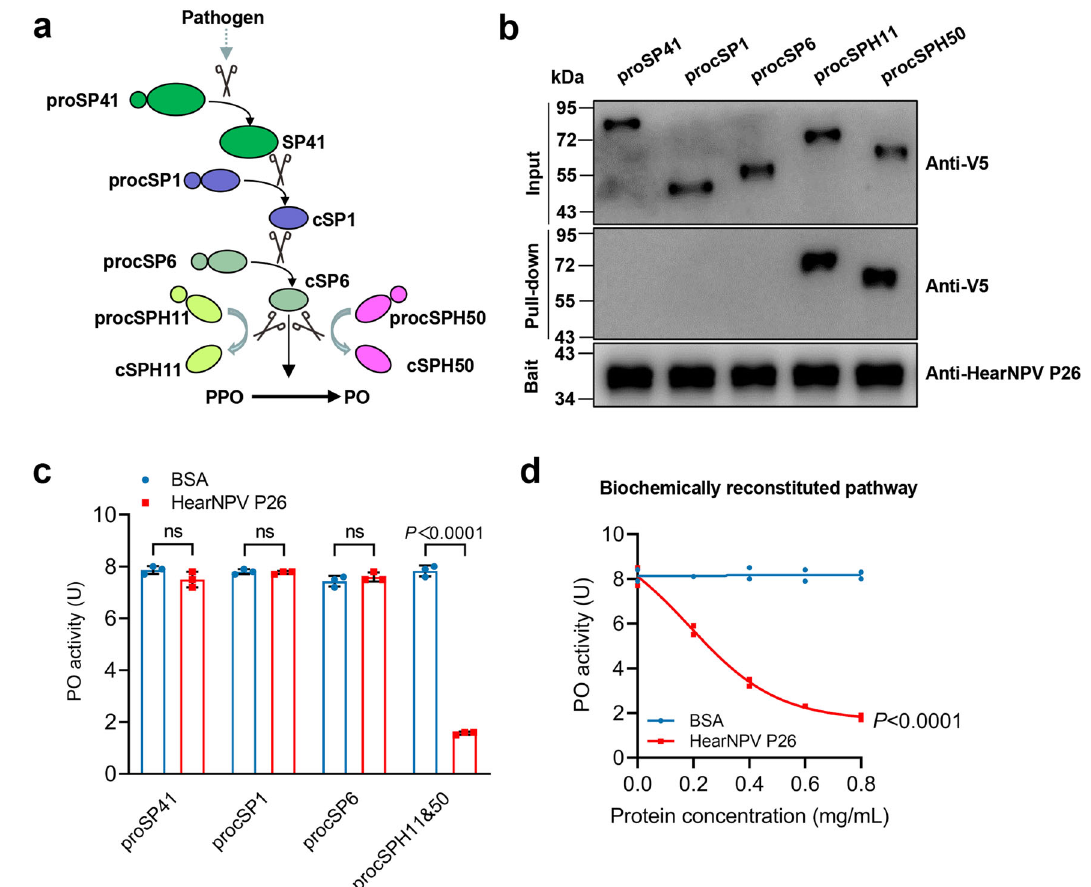
Fig. 3 | Molecular mechanism for inhibiting PPO activation by HearNPV P26. a Scheme of the PPO activation pathway of H. armigera hemolymph. Activation of proSP41 initiates activation of downstream procSP1 and procSP6 successively, causing PPO activation. The cofactor precursors (procSPH11 and procSPH50) are activatedbycSP6toenhancePPOactivationbycSP6. b Pull-downassayofHearNPV P26withproSP41,procSP1,procSP6,procSPH11,andprocSPH50.Therecombinant HearNPVP26containsatwin-streptag,andproSP41,procSP1,procSP6,procSPH11, or procSPH50 has a V5 tag. The samples were analyzed by SDS-PAGE and immu- noblotting using anti-V5and anti-P26antibodies. c Identi fi cation of the P26targets in the melanization pathway. P26 was pre-incubated with proSP41 Xa , procSP1, procSP6,orprocSPH11 and procSPH50,followed byincubationwiththe remaining components of the pathway prior to PO activity measurement. BSA was used as a